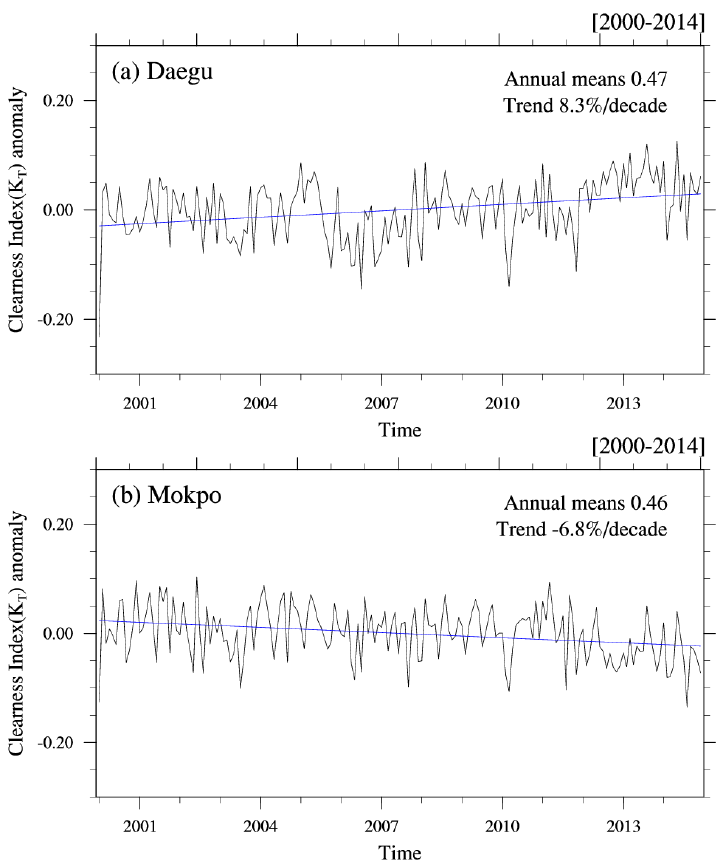
Figure 5. Long-term trend in the deseasonalized K T anomaly for the ( a ) Daegu and ( b ) Mokpo sites. Table 2. Long-term trends (Unit: %/decade, 15 years: 2000–2014) in K T , CA, RH, and AOD at sites in two regions, grouped by increasing and decreasing trends in K T . The analysis period at the site marked by an asterisk ( * ) was 7 years (2008–2014).